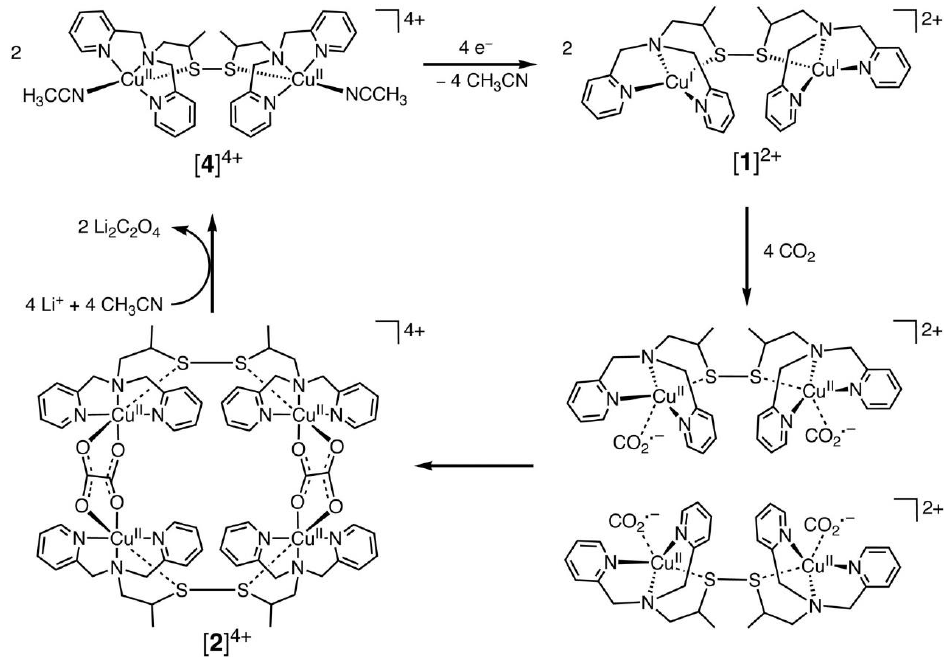
Figure 2. Proposed electrocatalytic cycle for oxalate formation. Reprinted from Ref. [78], copyright (2010), with permission from the American Association for the Advancement of Science.